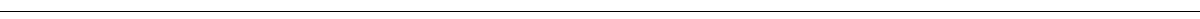
Fig. 5 NEDD9 as DLC1 interacting protein is required for the polarized expression of DLC1. a Venn diagram showing the number of proteins enriched by DLC1. b DLC1-associated proteins involved in major canonical pathways as assessed by the Ingenuity Pathway Knowledge base. c Interactome network of DLC1 and its associated proteins involved in cell motility and cytoskeleton regulation. d Immunoprecipitation (IP) was performed in neural tube lysate using anti-DLC1, and IgG as control. Immunoprecipitated proteins were resolved on sodium dodecyl sulfate-polyacrylamide gel electrophoresis gels, and Western blotting was performed with anti-NEDD9 and anti-DLC1 antibodies. e Schematic showing the design of the C-terminally truncated DN-DLC1 constructs. IP with anti-V5 was performed in lysates extracted from neural tubes electroporated with the indicated constructs followed by western blot with anti-V5 or anti-NEDD9. White arrowhead indicates the speci fi c protein band of DN-DLC1 (SAM). f In situ hybridization for NEDD9 , DLC1 , SOX9 and SOX10 on transverse sections of st 11 chick embryo. Immuno fl uorescence for NEDD9, SOX9 and SOX10 on transverse sections of st 11 chick embryo. Scale bar: 50 µ m. g Immuno fl uorescence for NEDD9 and phalloidin on emigrating NCCs from neural tube explants and nuclei are stained with DAPI. Polarized expression of NEDD9 is shown in pseudocolour. Line scan analysis showing the average fl uorescence intensity of NEDD9 along the white dotted line ( n = 103/11 explants). h Immuno fl uorescence for DLC1 and phalloidin on NCCs expressing control morpholino (Ctrl-MO) ( n = 65/11 explants) or NEDD9- MO ( n = 112/12 explants). Distribution of DLC1 expression in both treatments are shown in pseudocolour. Scale bars, 20 µ m. i Line scan analysis showing the average fl uorescence intensity of DLC1 in NEDD9-MO-treated NCCs ( n = 112/12